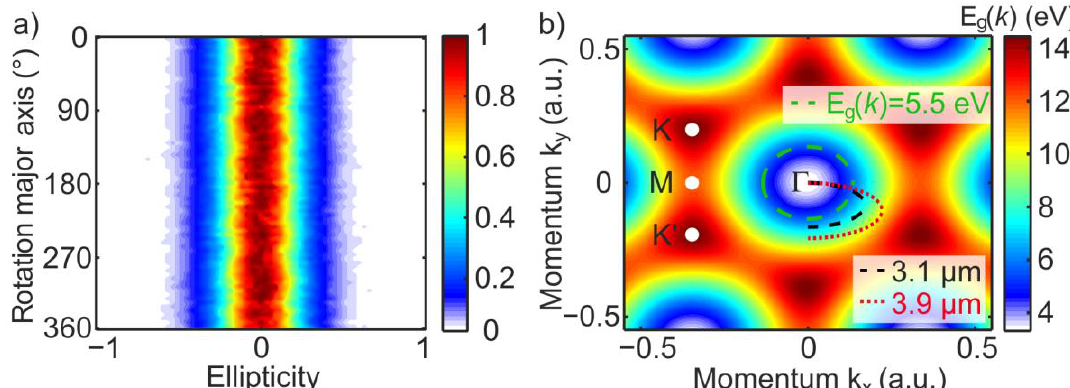
Figure 4. Effect of the electronic structure symmetry properties on the ellipticity dependence of the HHG process. ( a ) Ellipticity dependence of the 11th harmonic as a function of the laser polarization major axis rotation around the ZnO crystal c-axis. ( b ) Electron momentum-dependent band gap. The high symmetry points Γ , K, K’ and M are labelled. The area from the Γ-point to the green dashed circle highlights the condition 𝐸 𝑔 ( 𝑘⃗ ) < 5.5 eV. This is the region where experimentally detectable harmonics are generated. The black dashed and red dotted lines indicate the electron trajectory upon strong field interaction when a 3.1 and 3.9 µm laser and an ellipticity of 0.5 is used, respectively.